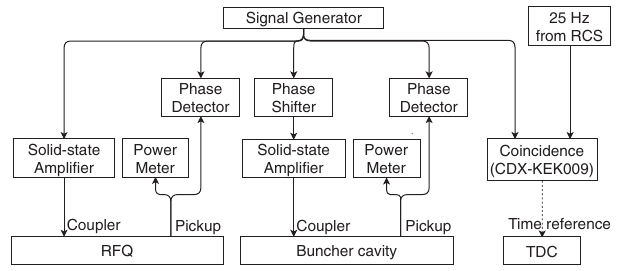
FIG. 6. Rms envelope calculation with TRACE 3 D [31] for the period from the RFQ exit to the MCP of the BWM. The units are in mm-mrad in the x − x 0 and y − y 0 phase planes and deg-keV in the Δ ϕ − Δ W phase plane.